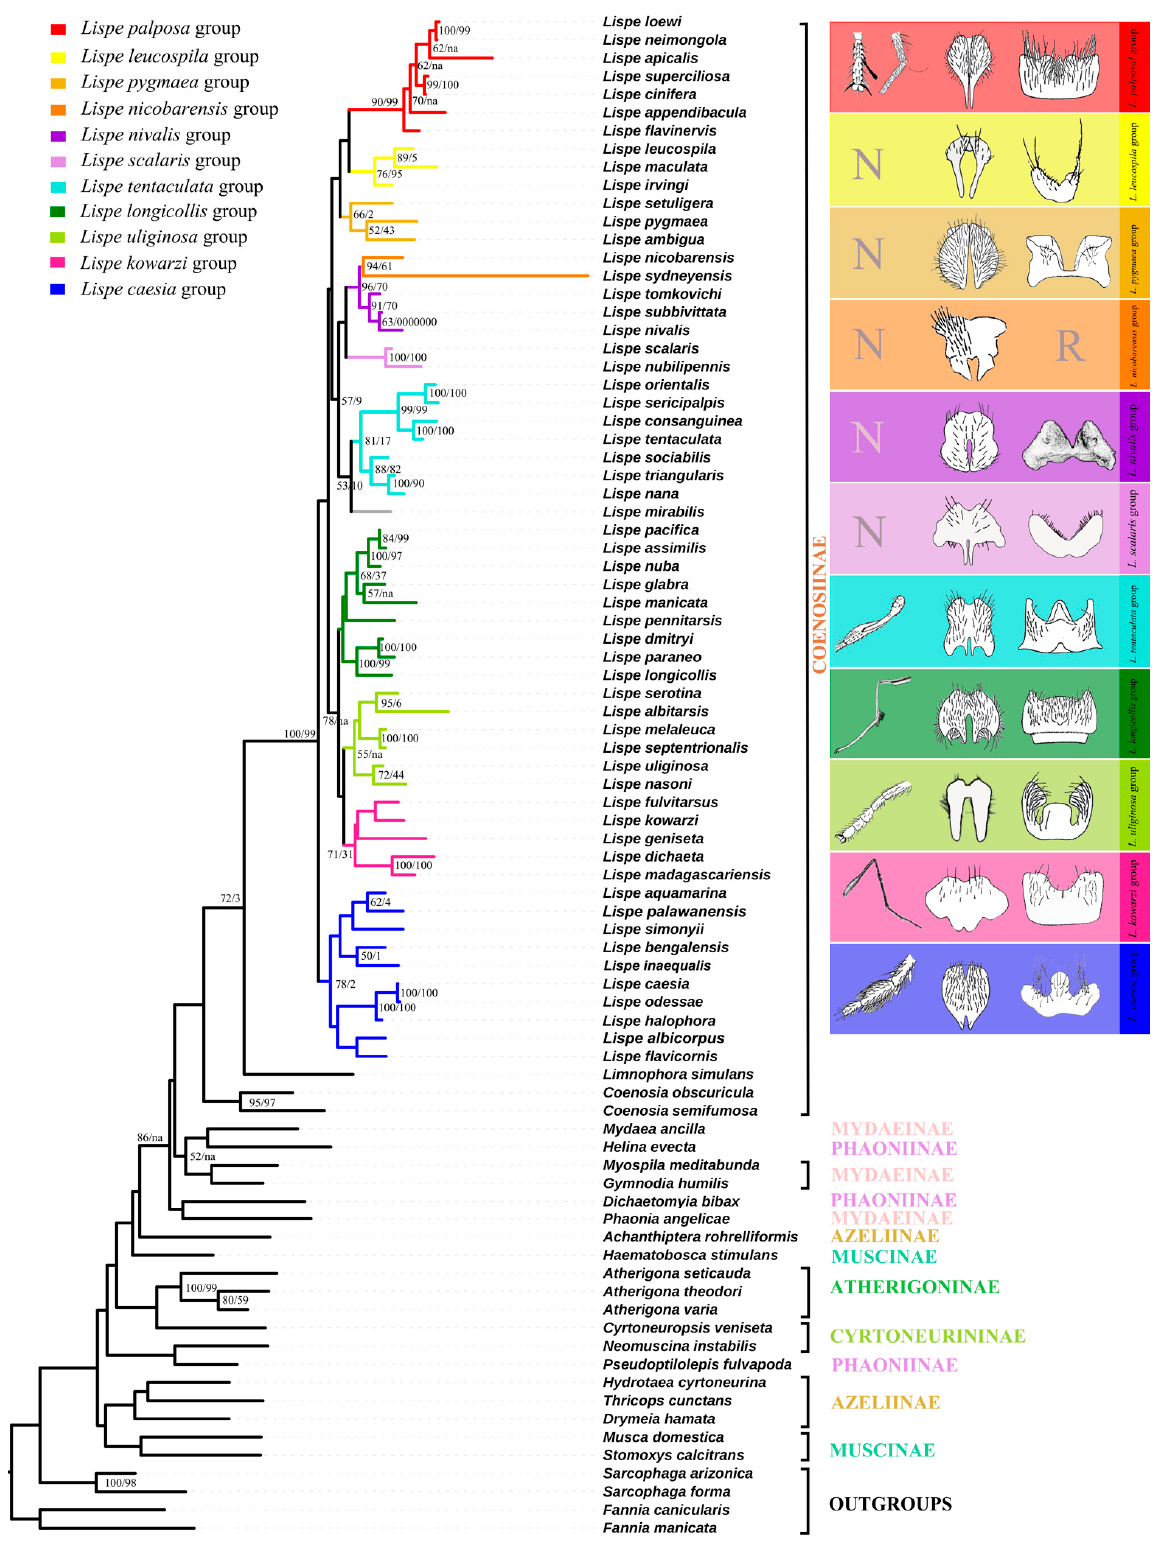
Figure 2. The topologies of maximum likelihood trees based on all selected genes with third codon positions, mapped with morphological and biological characters. N represents the unmodified normal legs. R represents that sternite 5 is reduced. Bootstrap/Jackknife node support values for the ML and MP trees are indicated with on the branches of the tree respectively, bootstrap values less than 50 are not indicated on the tree. Branches indicated with na are not supported on MP